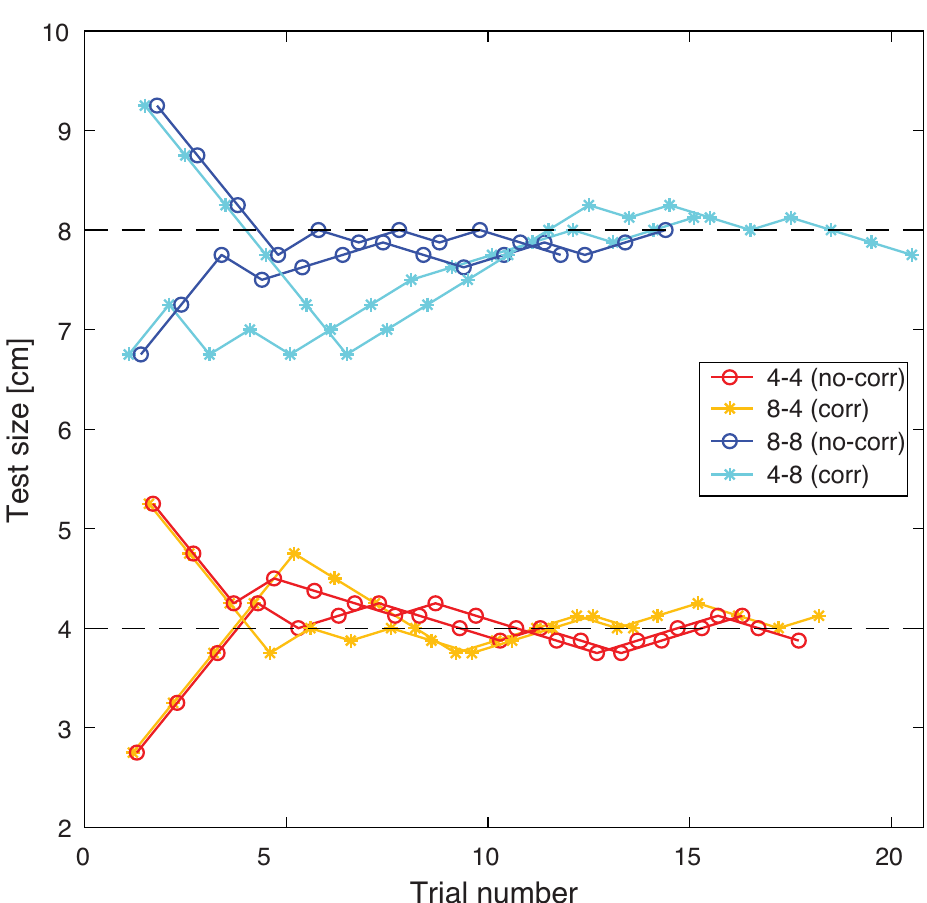
Fig 2. Example of staircase procedure for a representative participant in Experiment 1. Each condition has two staircases, one starting at a high and one at a low value in the test set. Circles represent no-correction (no-corr) conditions (4–4: no-correction small and 8–8: no-correction large) and asterisks indicate correction (corr) conditions (8–4: correction small and 4–8: correction large). The 9 th series with 4 and 8 cm objects is not shown here. Dashed lines indicate the size of the reference